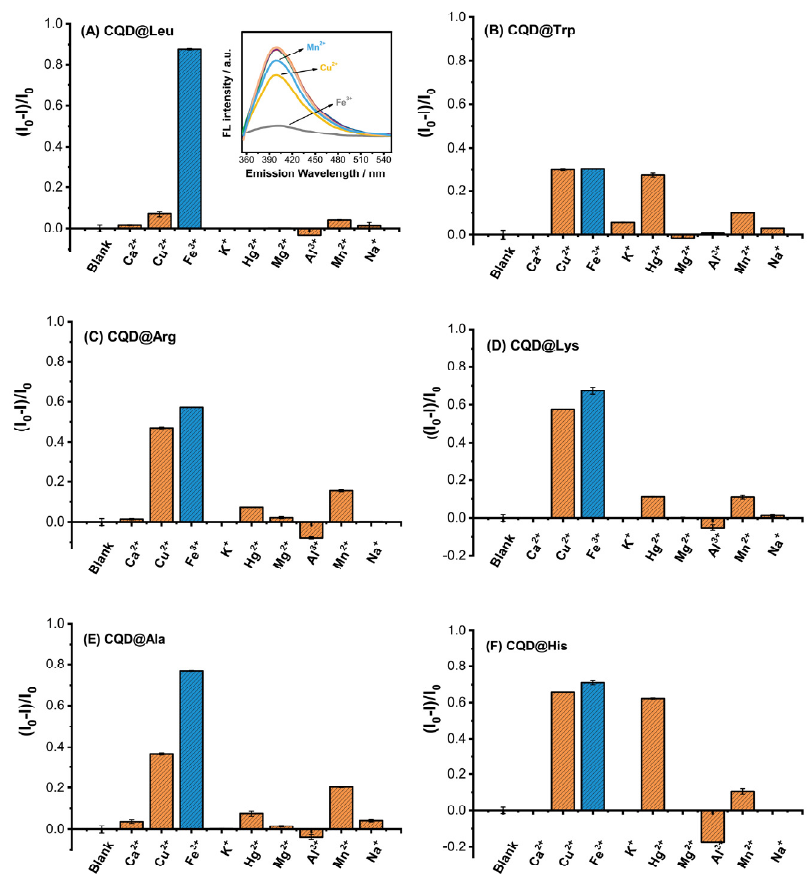
Figure 11. Fluorescence response of the samples CQDs to different metal ions: ( A ) CQD@Leu